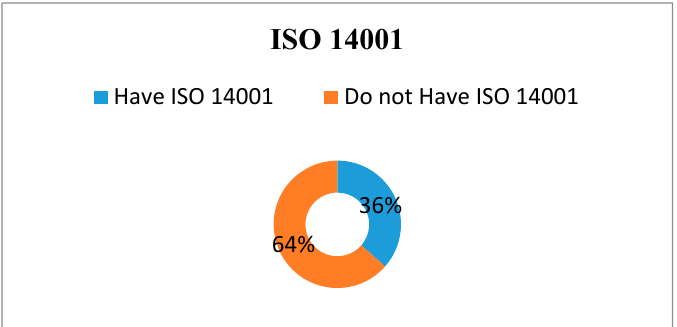
Figure 7. ISO 14001 Certificates portion.